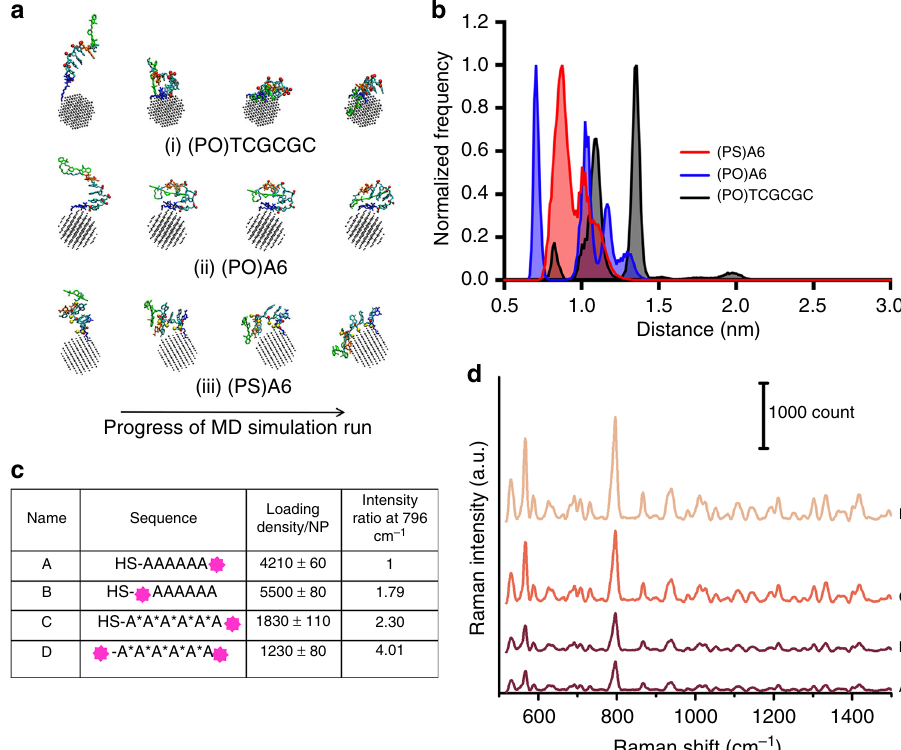
Fig. 3 DNA shell selection. a Snapshots of (i) HS-(PO)TCGCGC-Cy7, (ii) HS-(PO)A6-Cy7, (iii) HS-(PS)A6-Cy7 DNA folding onto 1.2nm AuNP surface at different time points of molecular dynamics simulations. Color coding, green: Cy7, orange: 3 ′ residue, blue: 5 ′ residue, red balls: O-atoms, yellow balls: S-atoms, gray: Au atoms. b The AuNP surface- fl uorophore distance distributions of HS-(PO)A6-Cy7 (blue, d average = 0.97nm), HS-(PS)A6-Cy7 (red, d average = 0.92nm), and HS-(PO)TCGCGC-Cy7 (black, d average = 1.22nm) at equilibrium showing very close proximity of the fl uorophore to the AuNP surface for fi rst two sequences. c Speci fi cations of the 4 different DNA sequences functionalized with Dylight TM -780 fl uorophores. d The baseline-subtracted Raman-spectra of FRNPs (10fM) derived from the sequences A – D demonstrating that FRNPs derived from sequence D have the highest signal